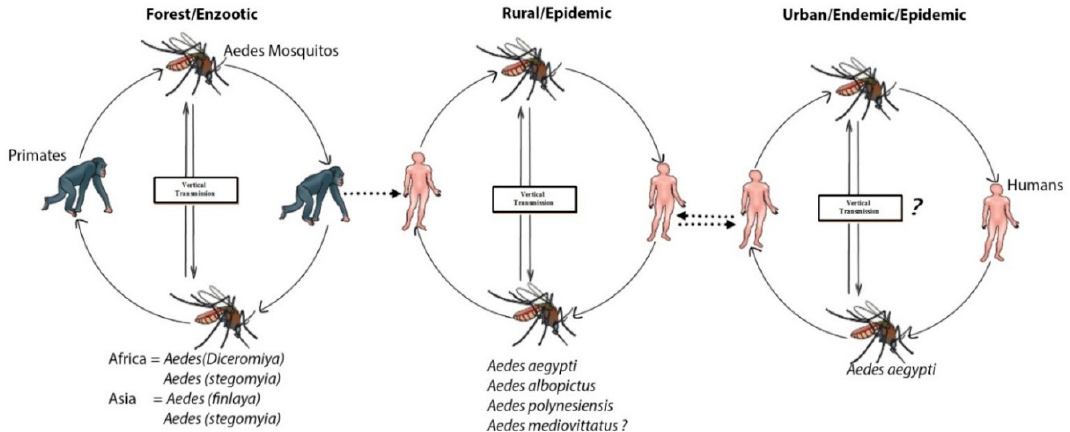
Figure 1. Sylvatic transmission of dengue virus (DENV) from lower primates to humans: Serotypes of DENV-1–4 emerged independently via the sylvatic cycle and subsequently disseminated among human populations. The forests of Southeast Asia and West Africa maintained the sylvatic cycle and supported contact with human populations, leading to an urban endemic / epidemic cycle between Aedes mosquitoes and human repository hosts.